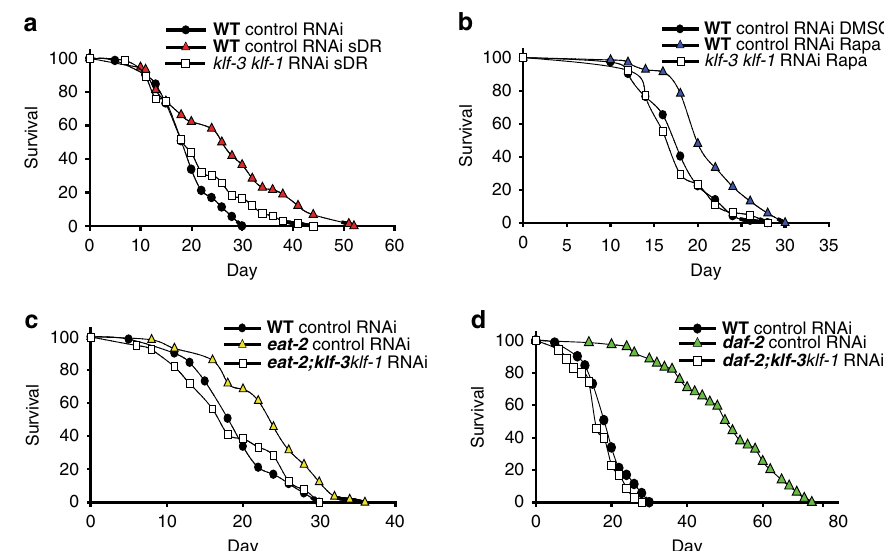
Fig. 1 KLFs are required for long lifespan in multiple longevity paradigms. Lifespan analysis of animals subjected to solid agar dietary restriction at 10 8 cfu/ ml OP50 (sDR) ( a ), 100 µ M rapamycin (Rapa) ( b ), eat-2(ad1116) animals ( c ), and daf-2 ( e1370 ) animals ( d ) after double loss-of-function of klf-1 and klf-3 . Animals were crossed into klf-3(ok1975) mutant to achieve klf-3 loss of function, and RNAi feeding targeting klf-1 was used to achieve klf-1 loss of function starting from day 1 of adulthood. sDR and rapamycin treatments were initiated from day 1 of adulthood to avoid developmental alterations. All lines were raised and maintained on OP50 at 20 °C. Strain is represented in bold . P -value < 0.05 by Mantel – Cox log-rank tests. Data are reproduced in Supplementary Fig. 3 with inclusion of klf-1 loss-of-function groups. See also Supplementary Table 3 for details of lifespan analyses and replicate